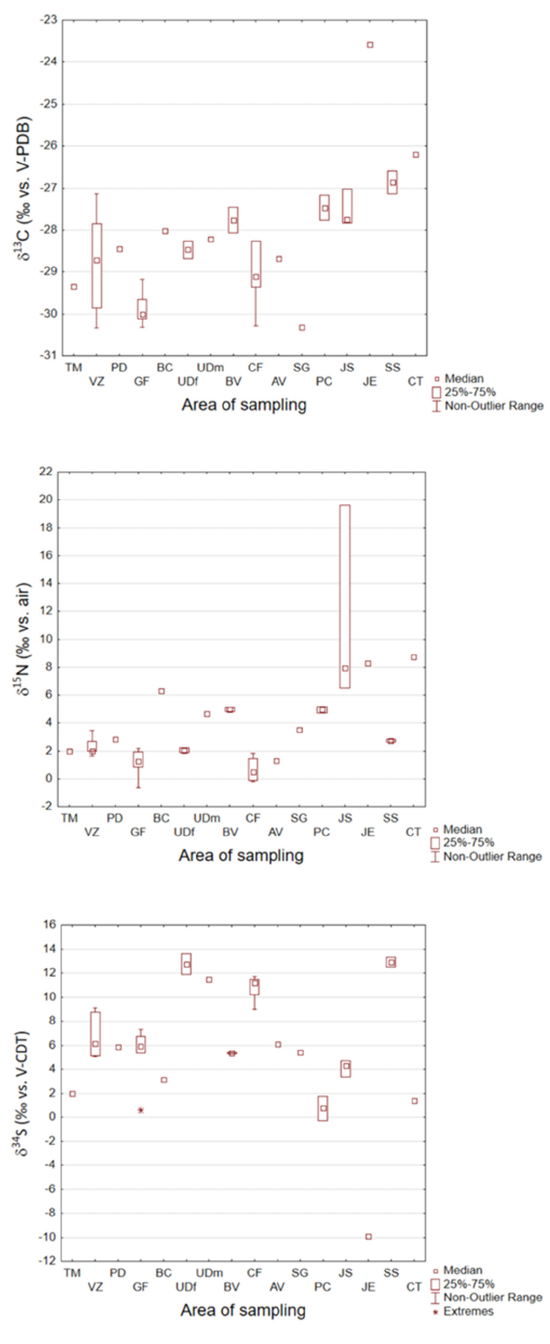
Figure 2. Box-plots of δ 13 C, δ 15 N, and δ 34 S values, expressed in ‰, of Italian industrial hemp inflorescence samples ( Cannabis sativa L.) ordered according to the latitude of the sampling areas (from the highest to the lowest). V-PDB = Vienna-Pee Dee Belemnite, V-CDT = Vienna-Canyon Diablo Troilite, TM = Tolmezzo (UD), VZ = Verzegnis (UD), PD = Predaia (TN), GF = Gemona del Friuli (UD), BC = Baceno (VB), UD = Udine ( f = grown under synthetic fertilization, m = grown under bovine manure fertilization), BV = Borgo Valbelluna (BL), CF = Campoformido (UD), AV = Altopiano della Vigolana (TN), SG = Seren del Grappa (BL), PC = Piacenza, JS = Jolanda di Savoia (FE), JE = Jesi (AN), SS = Sassari, CT = Caltagirone (CT). Map of the 2018 (red stars) and 2019 (black circles) sampling sites.